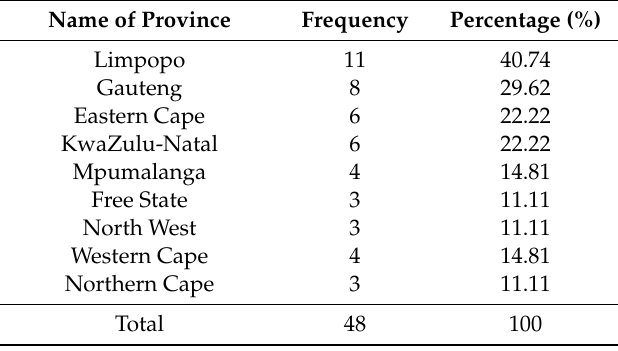
Table 2. The geographical distribution of the reviewed studies by province.